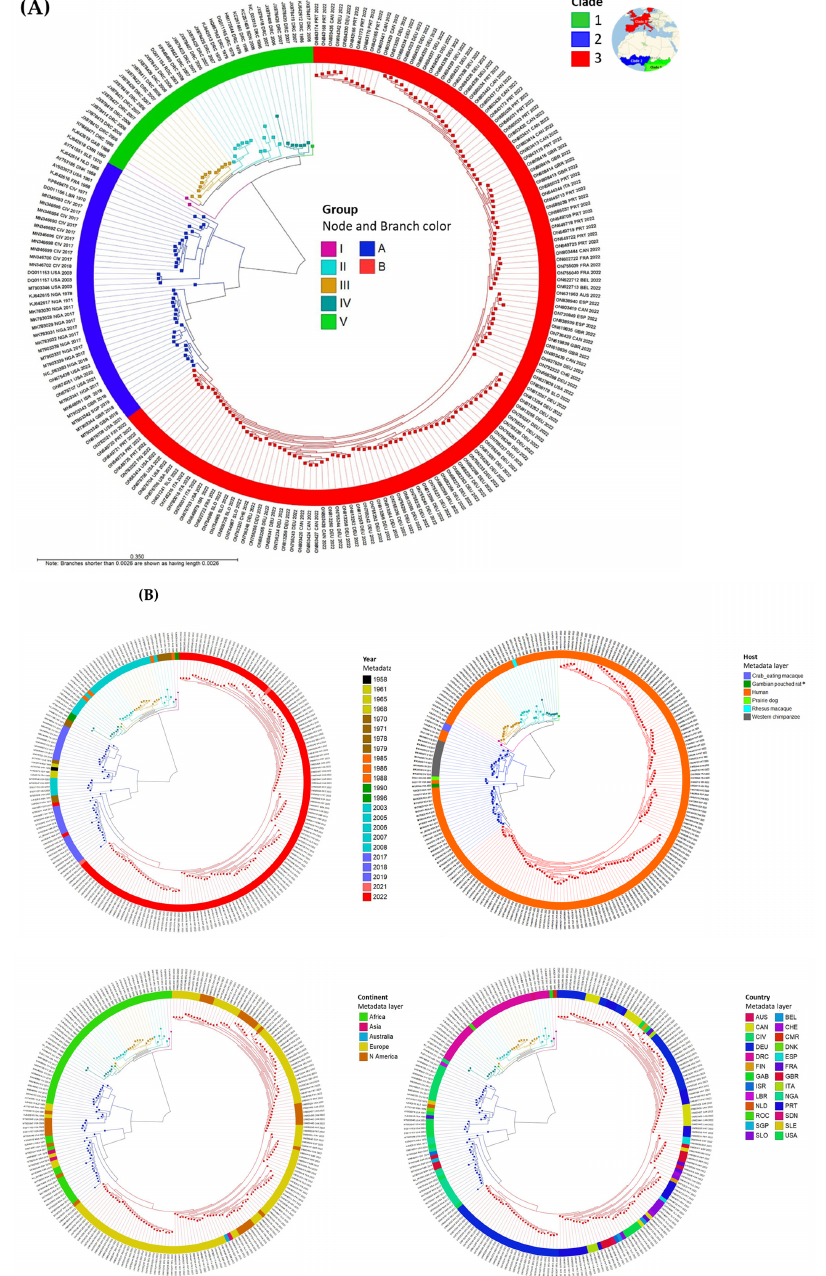
Figure 4. Circular phylograms of MPXV genomes by metadata for temporal, host, and spatial visu ‐ alization ( A ) Phylogram of complete MPXV genomes ( n = 218) by clades. Clades 1 and 2 originated from Central and West Africa, respectively, with divergent branches. In contrast, Clade 3 descends from Clade 2 and consists of publicly available MPXV genomes from the 2022 global outbreak. The sublineages (group) of the clades reveal the relatedness of its member samples. Three attributes of each genome (sequence accession number, 3 ‐ letter country code, and year) are displayed as the outermost ring (label) of the phylogram; ( B ) Phylograms of the MPXV genomes by metadata, i.e., year (color ‐ coded by decades), host, continent, and country. The temporal, host, and spatial rela ‐ tionships reveal how the MPXV, first discovered in 1958, spilled over from mammals to humans, and spread quickly in 2022 out of Africa into Europe and North America. * The MPXV genomes of a Dormouse and Rope squirrel (USA, 2003) identical to that of a Gambian pouched rat are not shown. (The ANI NJ unrooted trees were constructed from the pairwise comparison table).